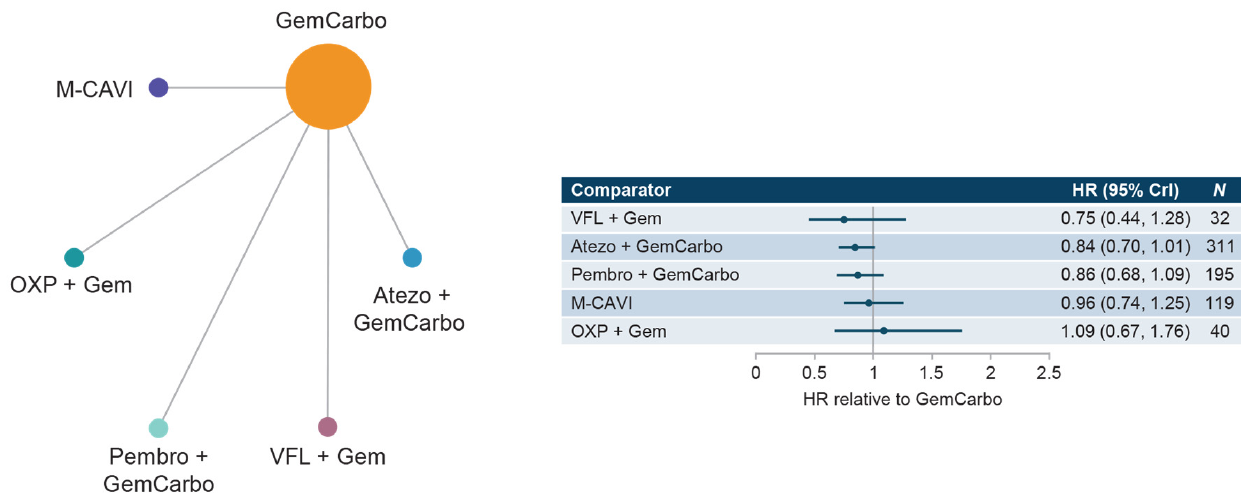
Figure 5. Network diagram and HR for PFS by treatment network for the cis-ineligible (wide) net-